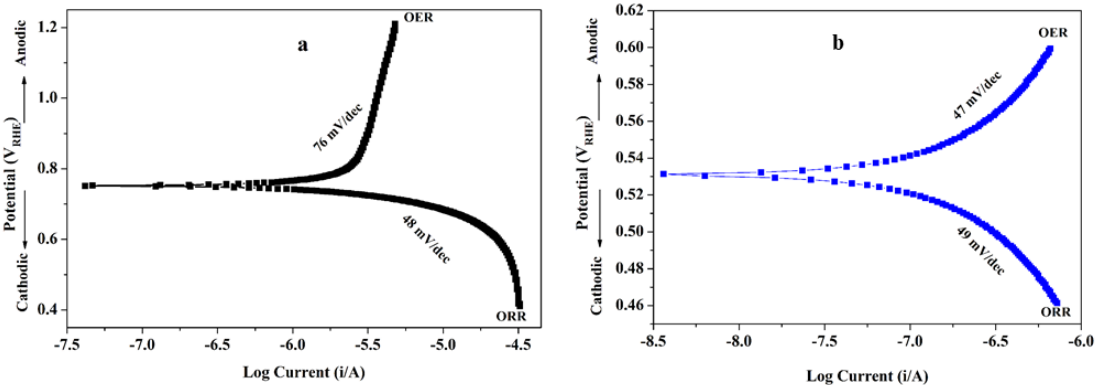
Figure 5. Tafel polarization curves of Ruthenium oxide nanoparticles for OER and ORR in ( a ) air, and ( b ) O 2 saturated atmosphere at 10 mVs − 1 . Table 1. Comparison of OER / ORR activity of RuO 2 nanoparticles with other reported literature.